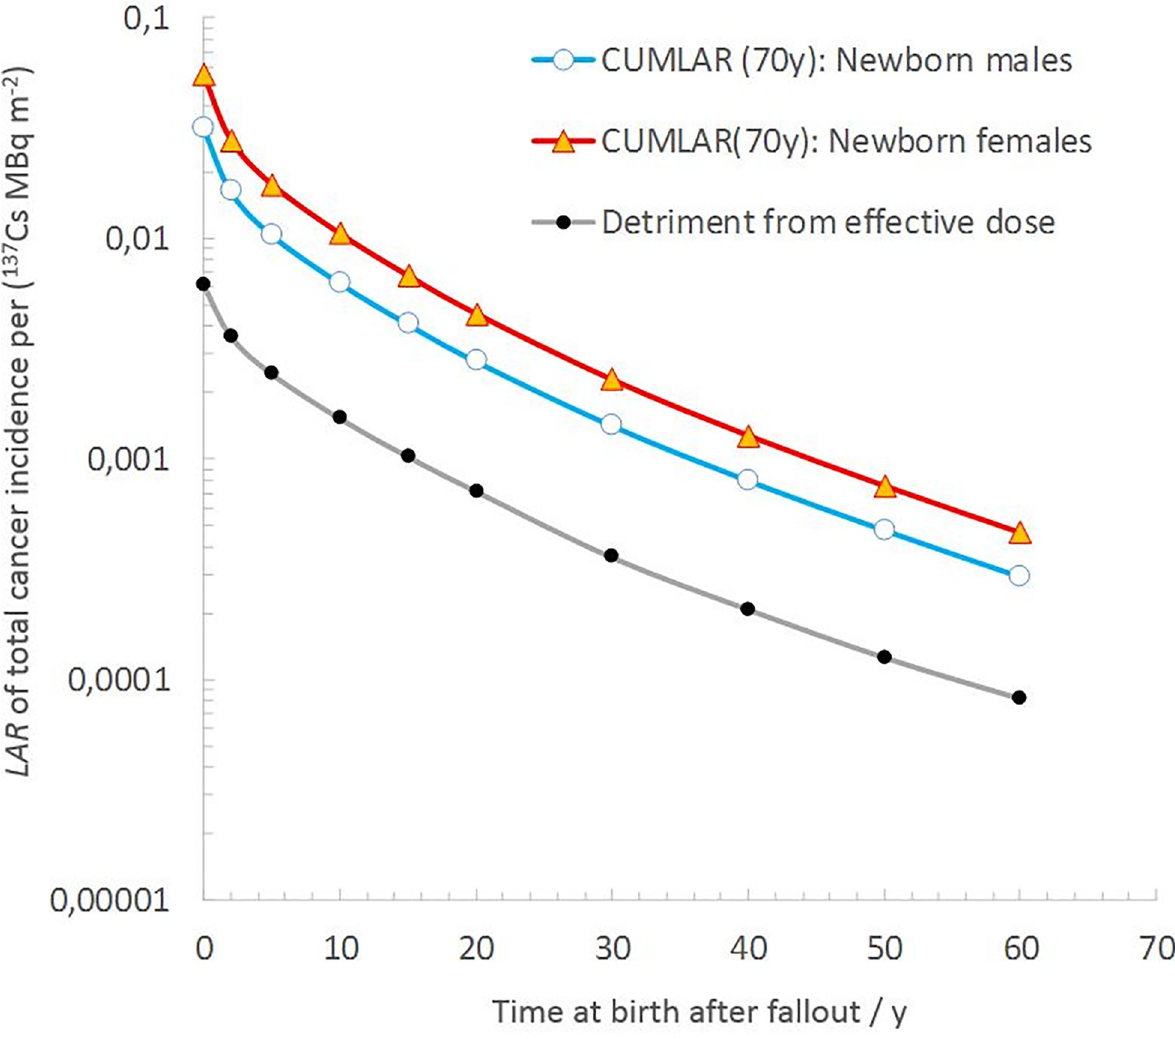
Fig 4. Cumulative lifetime attributable risk of total cancer (excluding non-fatal skin cancers) over 70 y for newborn offspring, born at time t b after the onset of fallout, for a population living in an area with an initial local- and regional-average 137 Cs ground deposition, A tot , reg , of 1 MBq m -2 . As a comparison, the detriment from effective dose is also